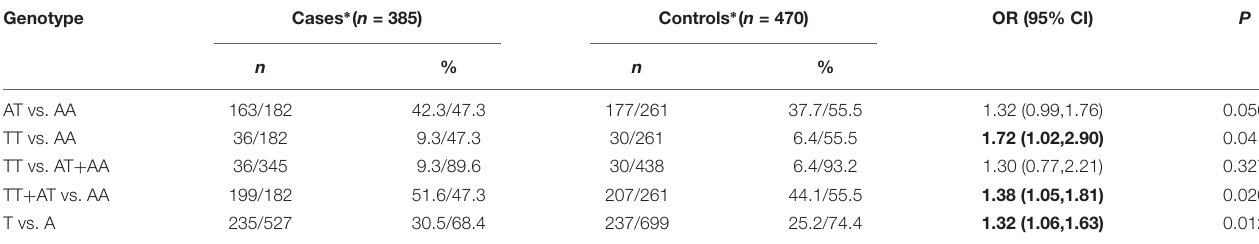
TABLE 2 | Logistic regression analysis of associations between AURKA rs2273535 polymorphism and risk of gastric cancer. Genotype Cases ∗ ( n = 385)